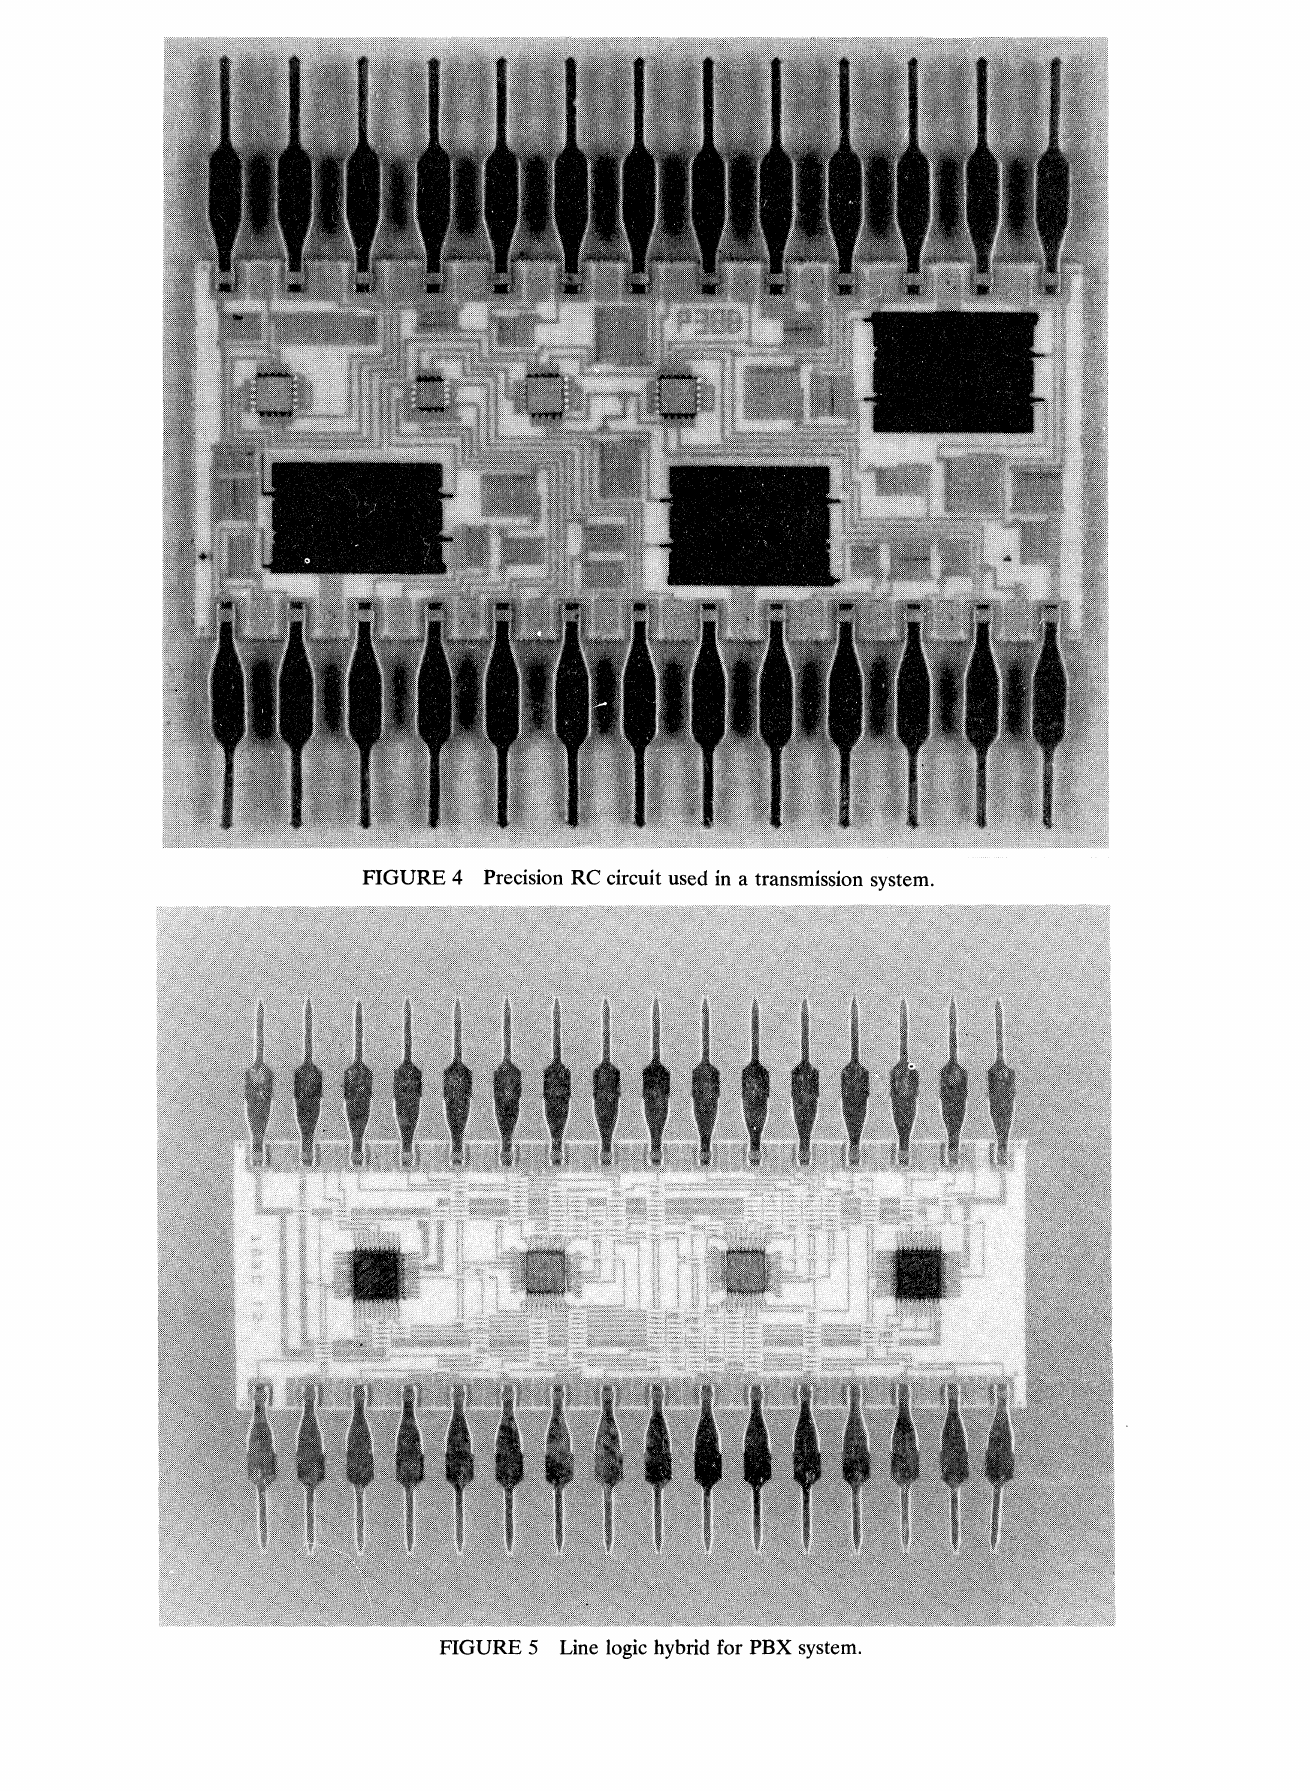
FIGURE 5 Line logic hybrid for PBX